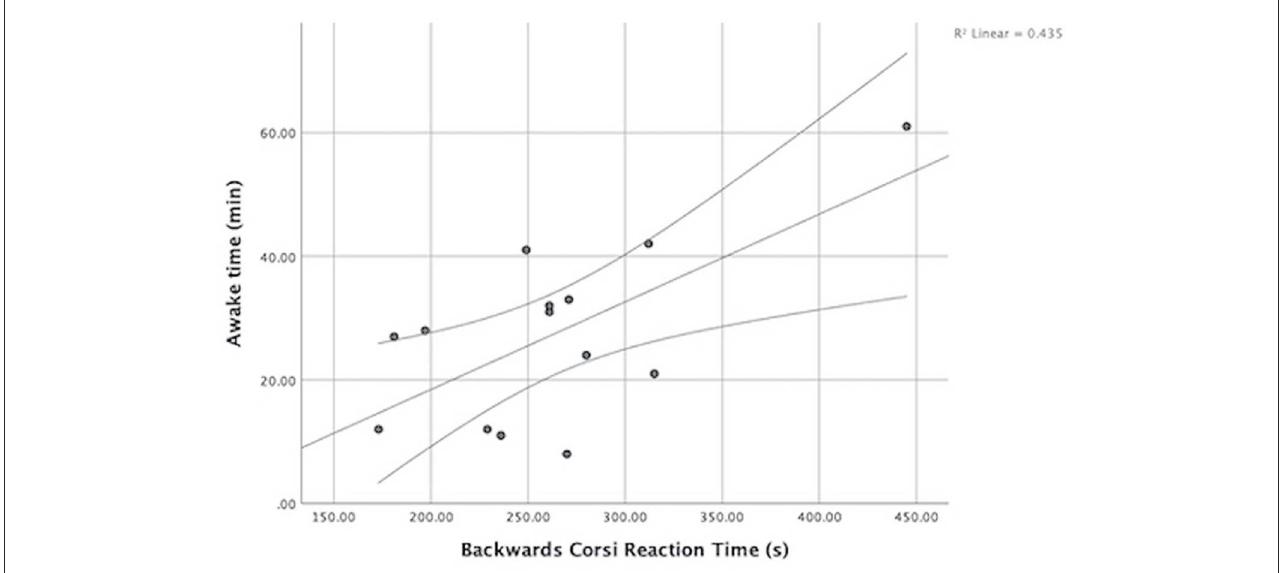
FIGURE2 Relation between awake time during night sleep (min) and mean RT (s) during the Backwards Corsi test. Athletes with little amount of interrupted sleep were faster in recalling memory.